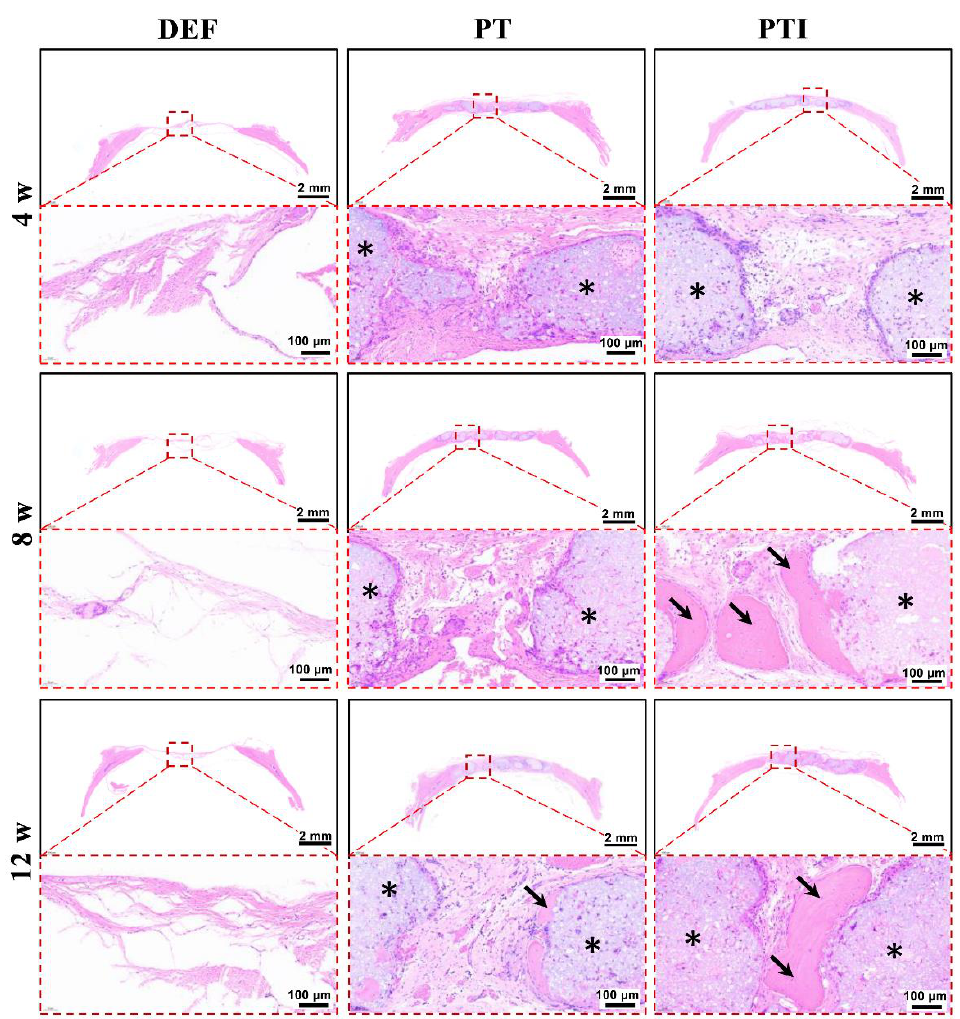
Figure 12. Microscopic appearance of tissue sections after H&E staining. Black stars indicate scaffolds, and black arrows denote new bone, where * is the part of the scaffold material shown after sectioning staining, while → refers to the new bone formed in the gap between the scaffolds.